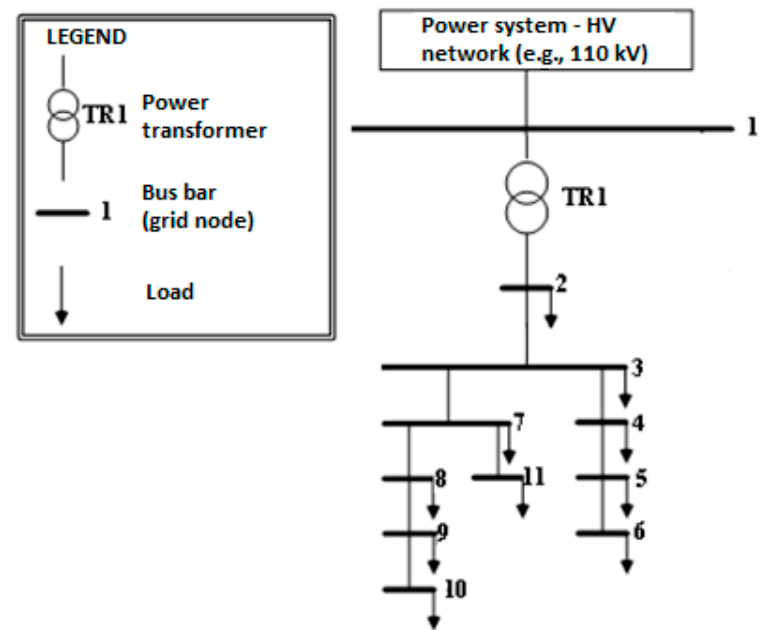
Figure 3. Benchmark model of medium voltage distribution network.